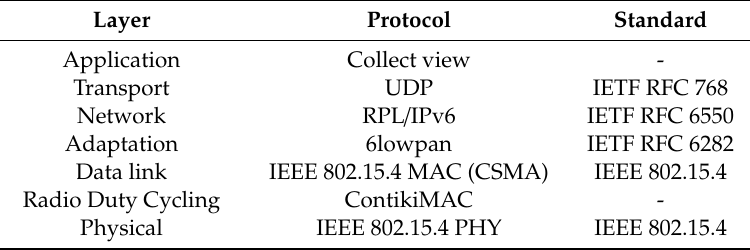
Table 3. Network layers structure used on the nodes [36]